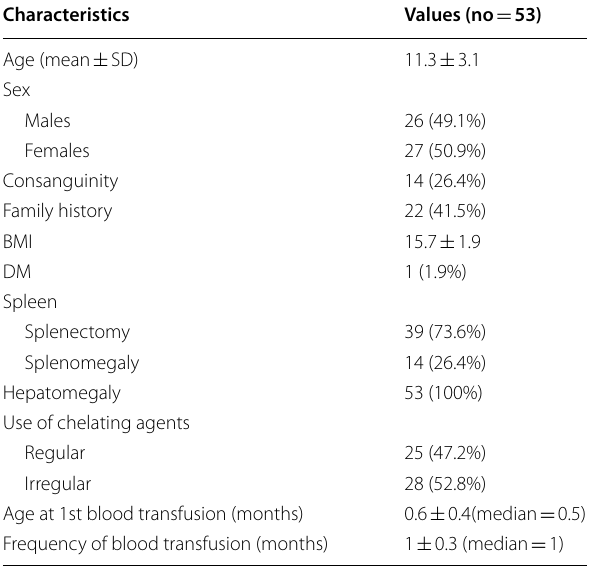
Table 1 Demographic characteristics of the studied patients